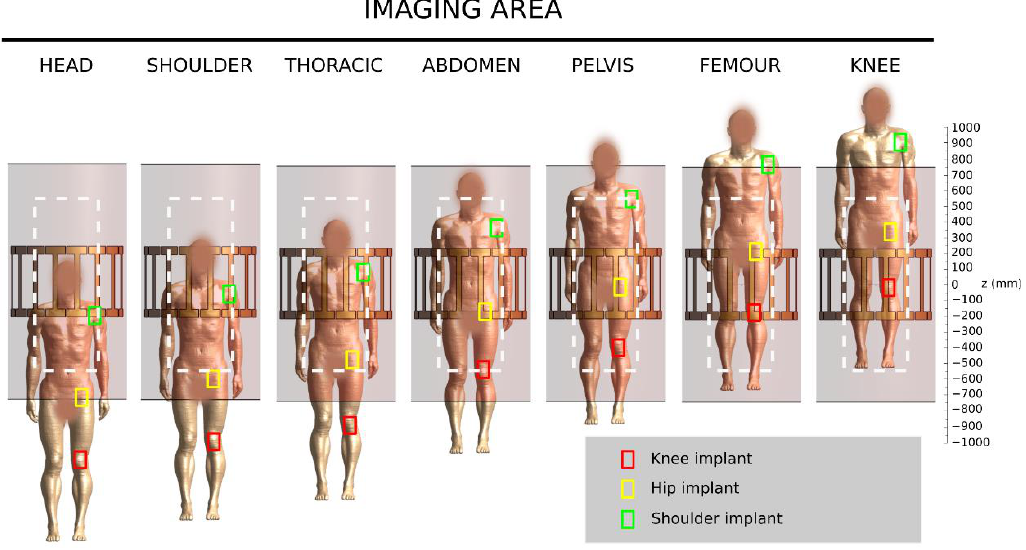
Figure 2. Positions of the human body with respect to the RF body coil and the GC (dark grey rectangle) for the considered imaging zones. The simulated implant positions are represented by the coloured rectangles and the phantom is represented by the dashed white rectangle.